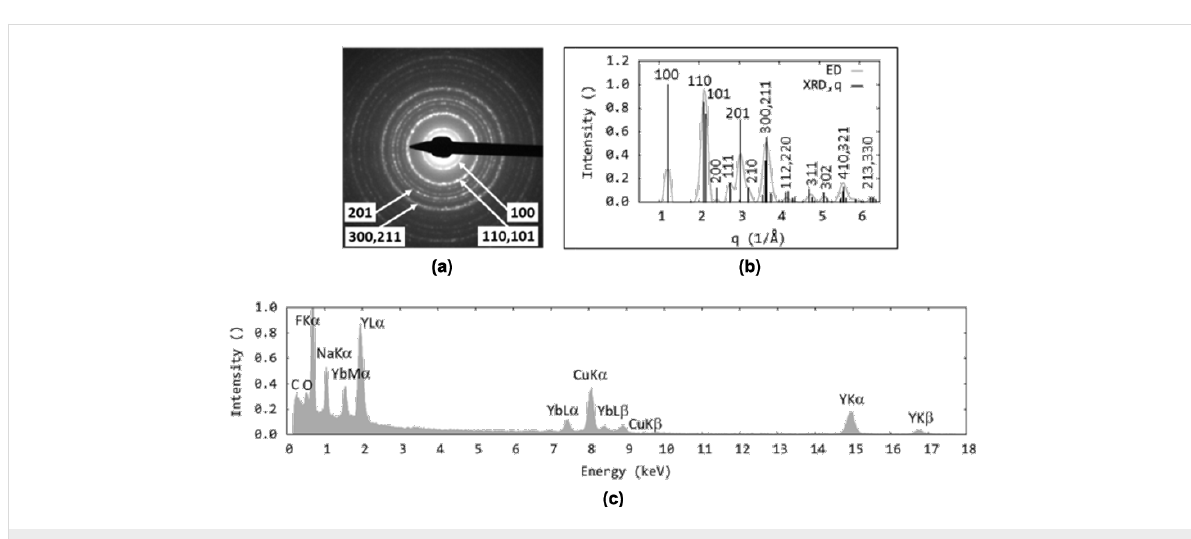
Figure 5: TEM analysis: (a) ED pattern, (b) comparison of experimental ED pattern and calculated XRD pattern, and (c) EDX spectrum of OM-NaYF 4 :Yb 3+ /Er 3+ nanoparticles no. 4. Peaks were indexed according to